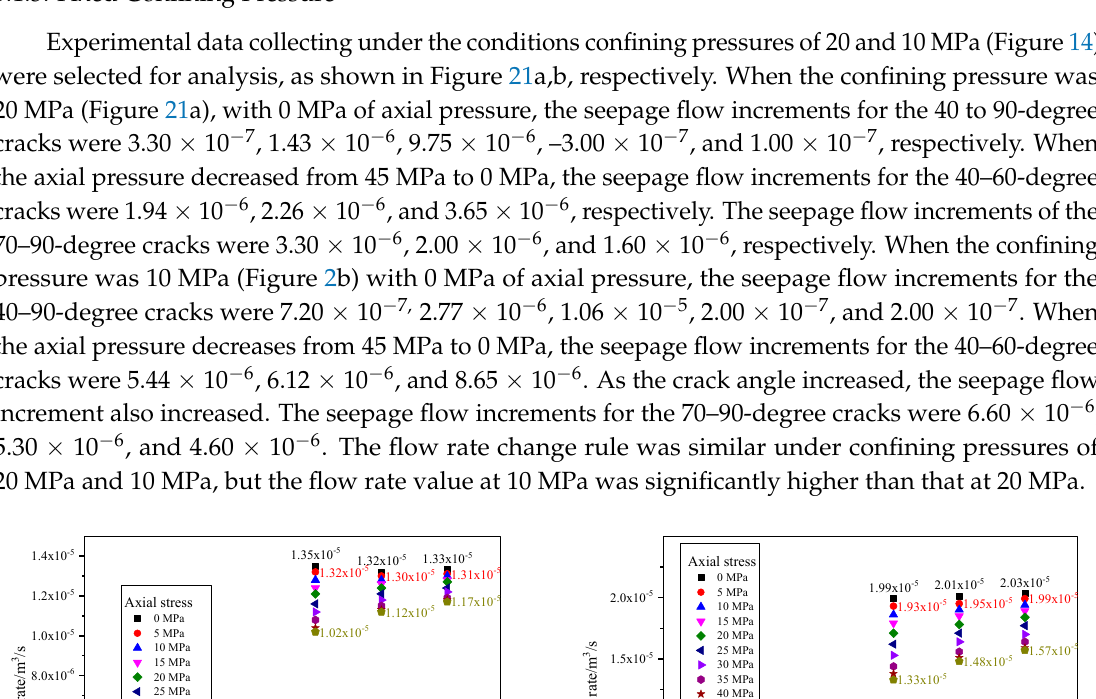
Figure 20. Flow rate change curves of different angles: ( a ) axial pressure 40 MPa and ( b ) axial pressure 10 MPa.